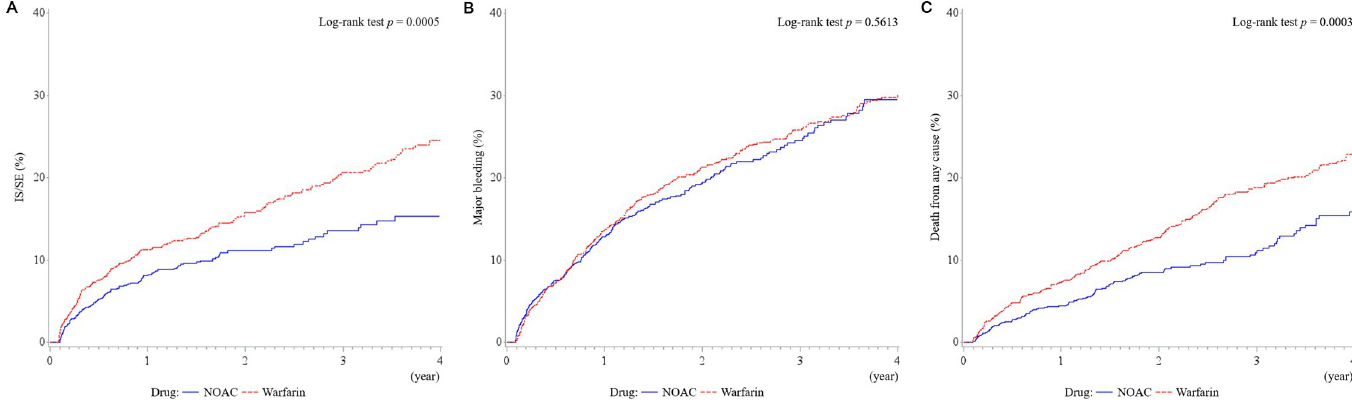
S1 Table. Hazard ratios for outcomes in patients with LAE (follow-up > 90